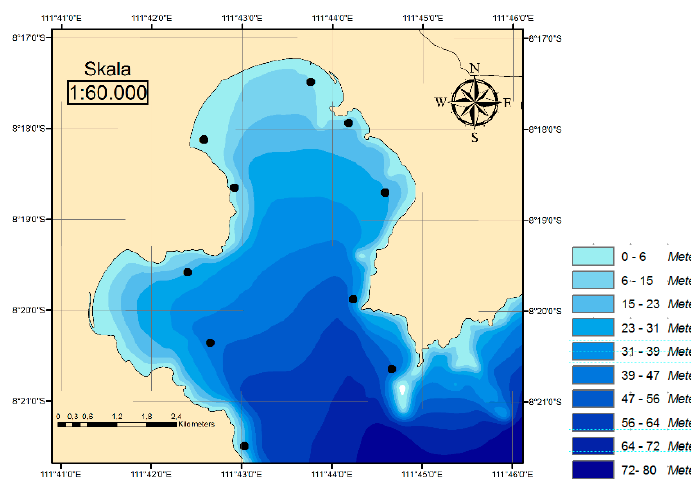
Figure 3. Bathymetry in Prigi Bay.